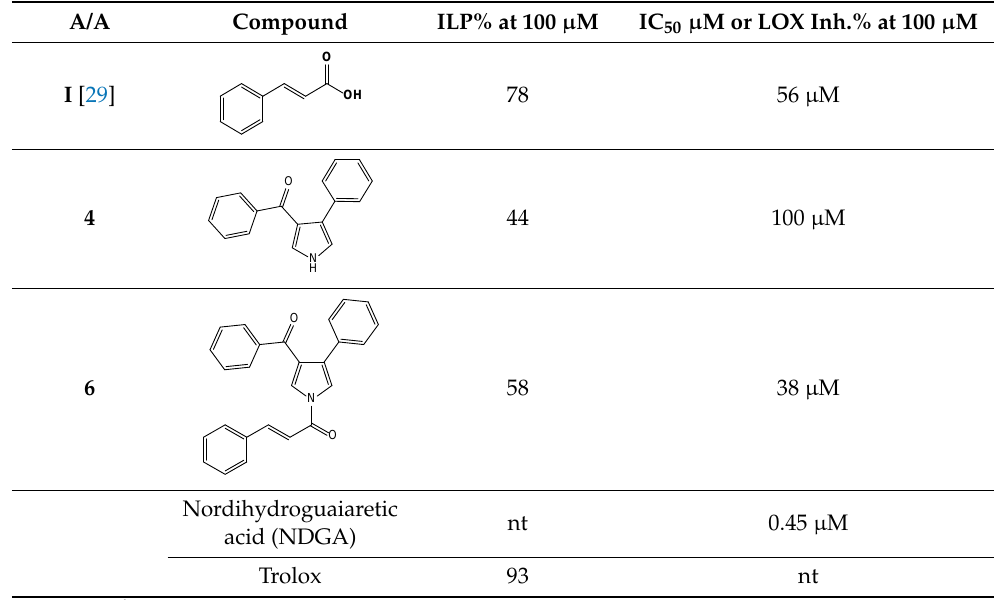
Table 2. % Inhibition of lipid peroxidation (ILP%) and in vitro inhibition of soybean lipoxygenase (IC 50 μM or LOX Inh.%).